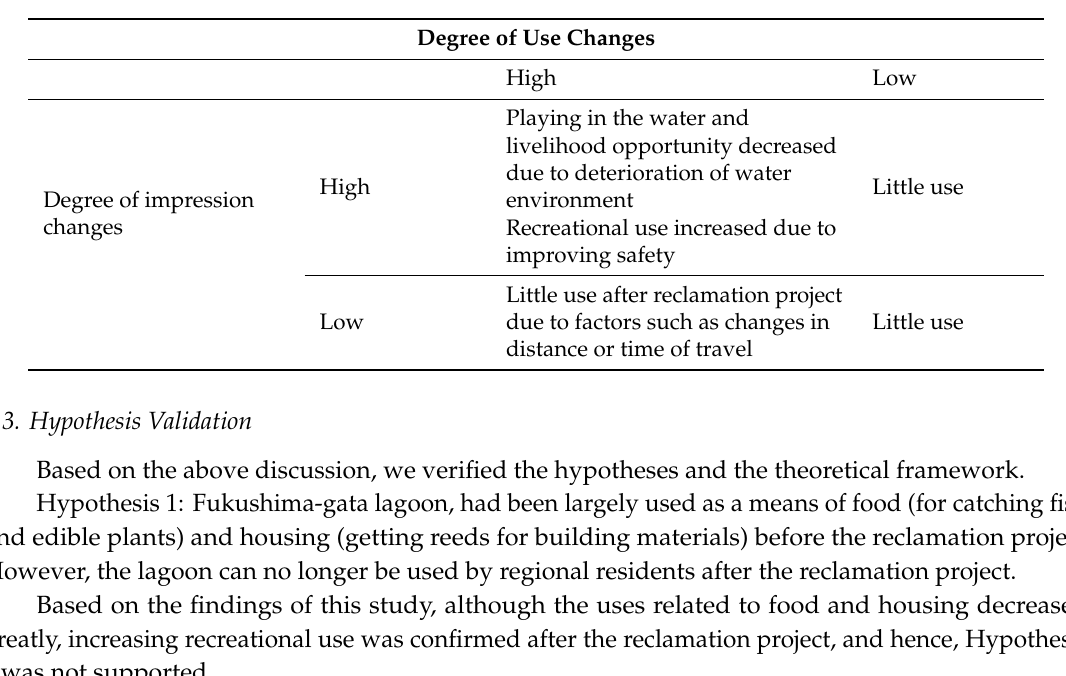
Table 5. Relationship between degree of changes in impression and degree of changes in